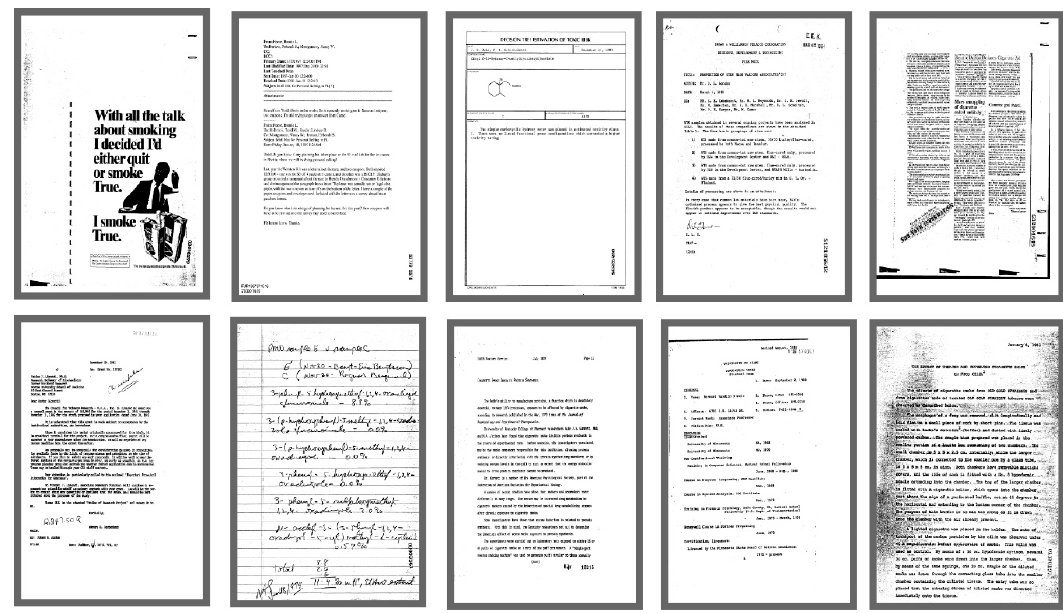
Figure 6. Sample images from Tobacco3482 dataset (one image per class). Left to right: (Advertisement, Email, From, Memo, News, Letter, Note, Report, Resume and Scientific).